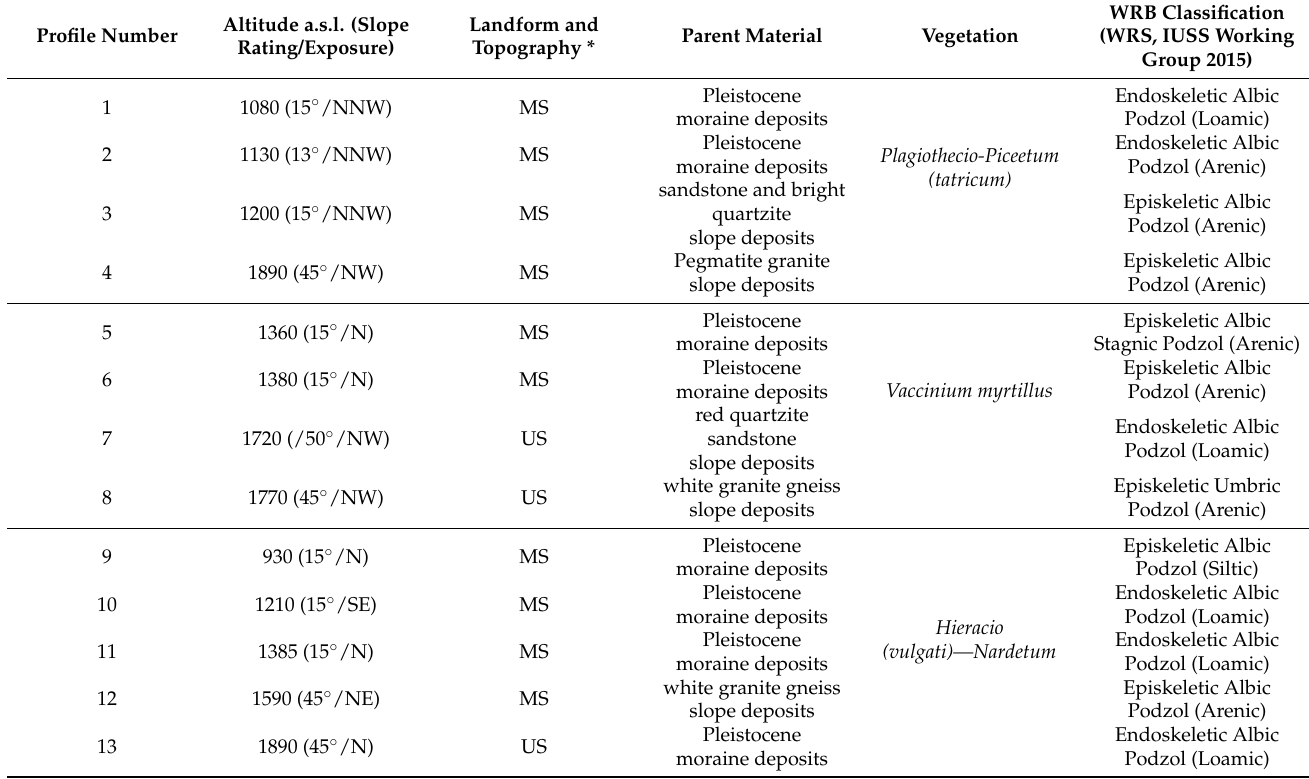
Table 1. Location sites, general information and classification of soil